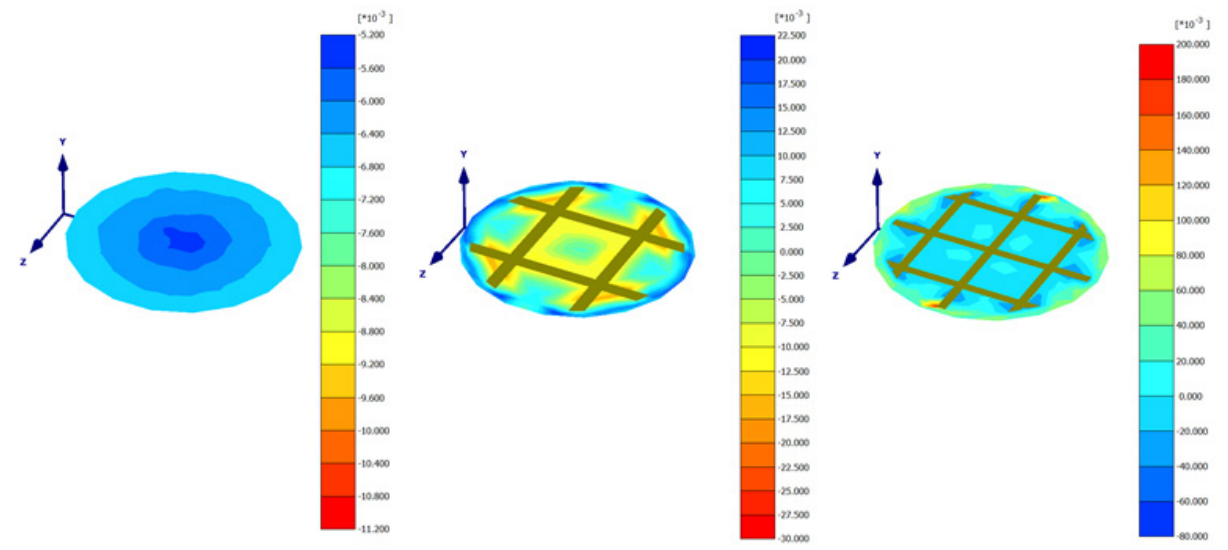
when the cell pressure σ = 100 kPa: left – unreinforced sample; middle – sample v 3